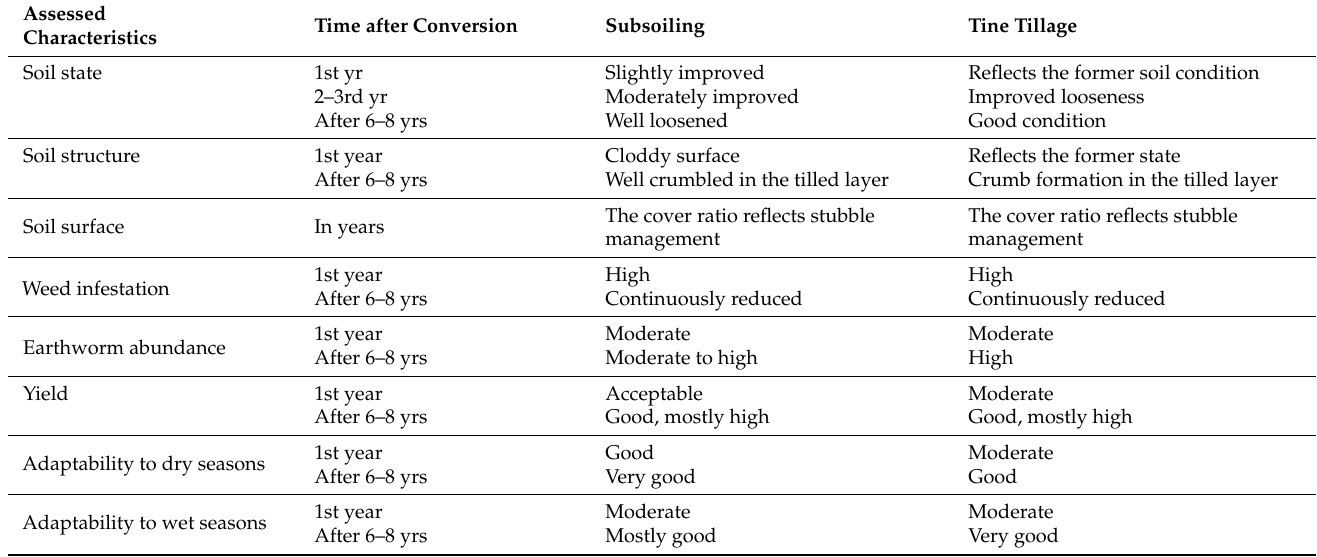
Table 2. Evaluation of subsoiling and tine tillage in the first years and in the long term based on Birk á s